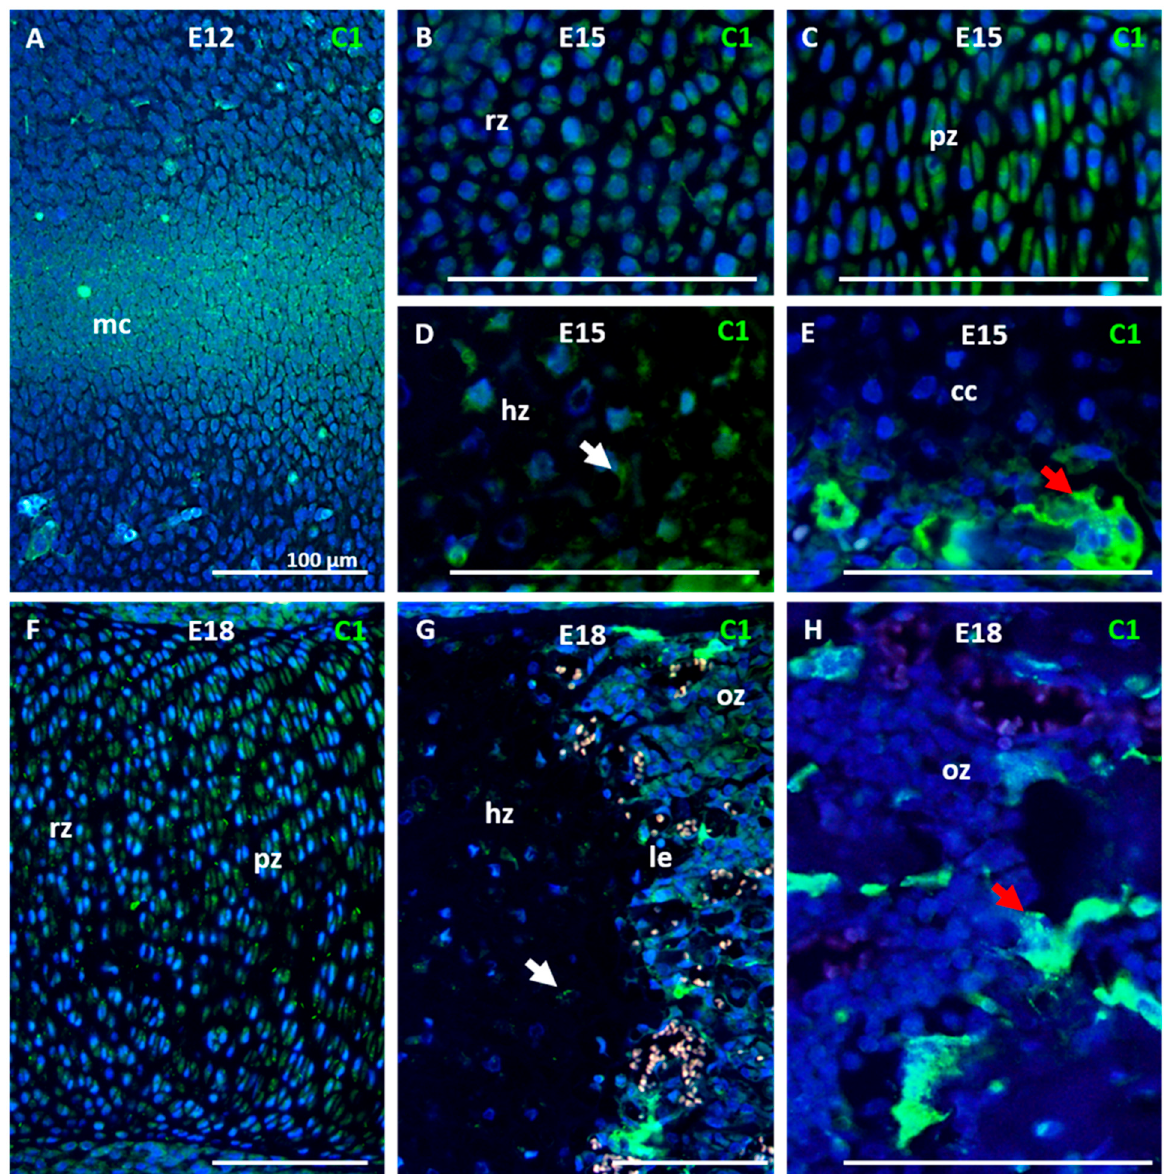
Figure 1. A temporospatial pattern of caspase-1 activation in the developing growth plate of a mouse forelimb. Detection of caspase-1 in condensed mesenchymal cells at the stage E12 ( A ). Detection of caspase-1 in resting ( B ), proliferating ( C ), and hypertrophic ( D ) zones of the growth plate at the stage E15. Detail of activation of caspase-1 in chondroclasts/osteoclasts penetrating to the primary ossification center ( E ) at the stage E15. Detection of caspase-1 in resting and proliferating ( F ), hypertrophic, and ossification ( G ) zones of the growth plate at the stage E18. Caspase-1 activation in osteoclasts of ossification zone at the stage E18 ( H ). The positive fluorescent signal is green, nuclei are counterstained by DAPI and are blue. The white arrows point to positive hypertrophic chondrocytes. The red arrows point to positive chondroclasts/osteoclasts. mc (mesenchymal condensation), rz (resting zone of the growth plate), pz (proliferating zone), hz (hypertrophic zone), cc (calcifying cartilage), oz (ossification zone). Scale bar = 100 μ m.